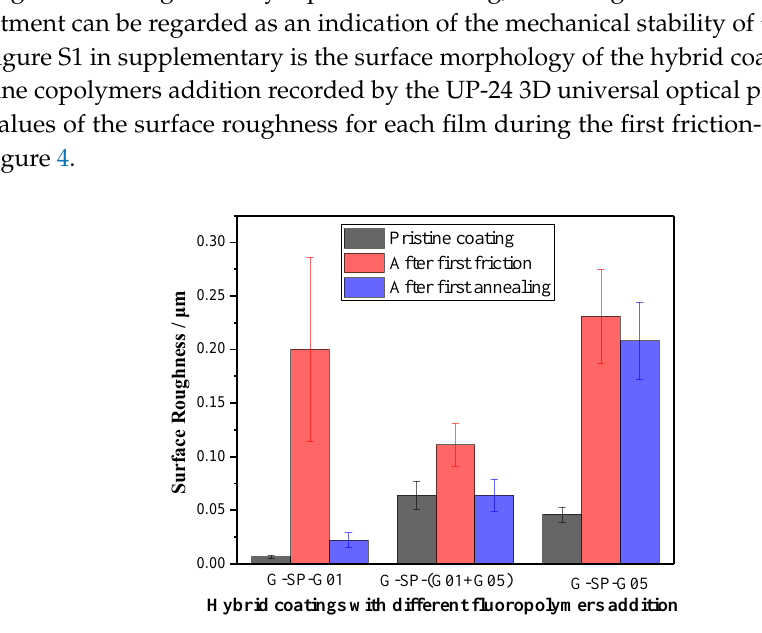
Figure 4. The surface roughness of the hybrid coatings during the first friction-annealing cycle.